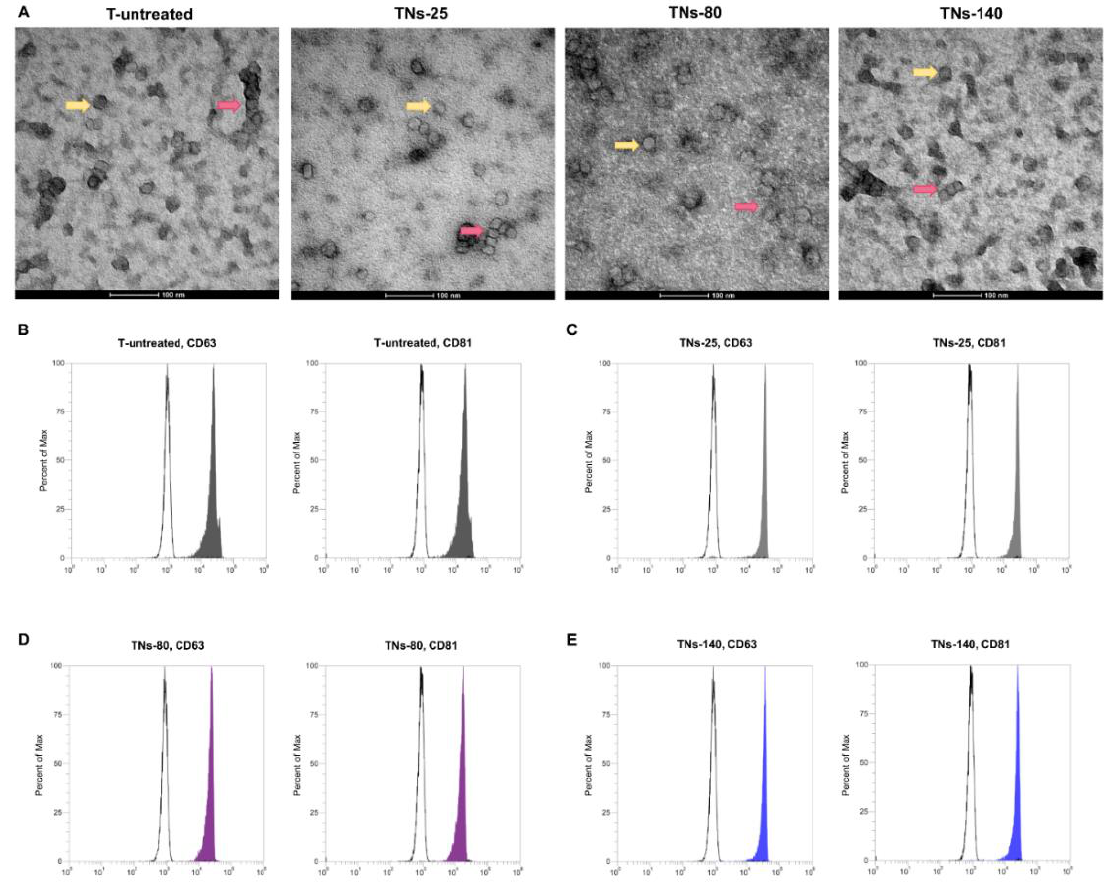
Figure 6. Characterization of exosomes isolated from hMSCs cultured for 7 days onto TNs. ( A ) TEM micrographs of exo-hMSCs recovered from T-untreated, TNs-25, TNs-80, and TNs-140 surfaces. Yellow arrows indicate distinct exosomes, whereas red arrows show exosomes aggregates. Flow cytometry of exo-hMSCs isolated from ( B ) T-untreated, ( C ) TNs-25, ( D ) TNs-80, and ( E ) TNs-140 surfaces showing positivity to CD63 and CD81 exosome surface markers.